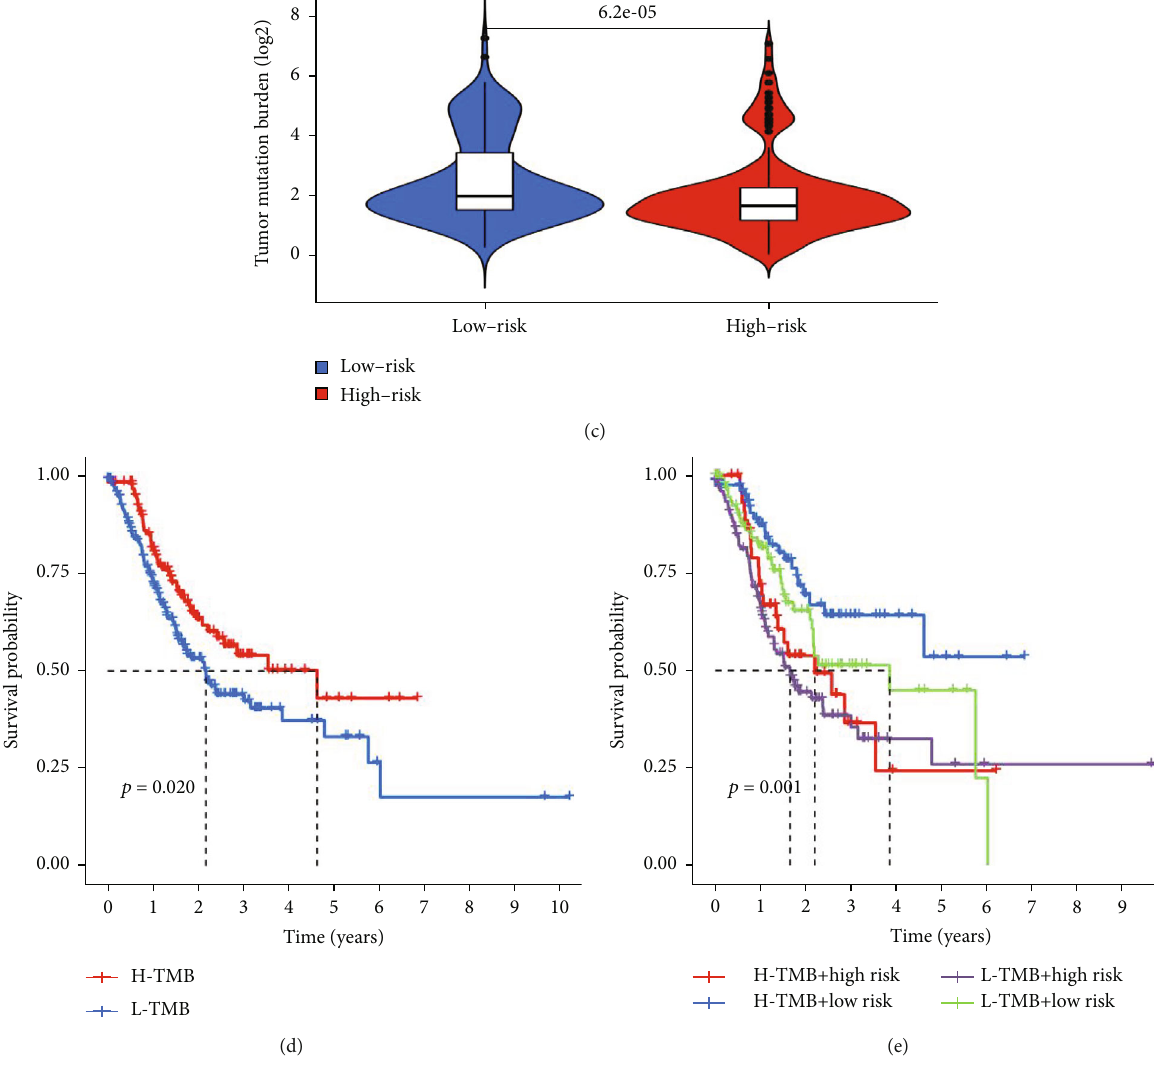
Figure 7: TMB analysis. (a) Waterfall diagram of high-risk group. (b) Waterfall diagram of low-risk group. (c) Di ff erence analysis diagram of tumor mutation burden. (d) Survival analysis of tumor mutation burden. (e) Survival analysis of TMV+ risk